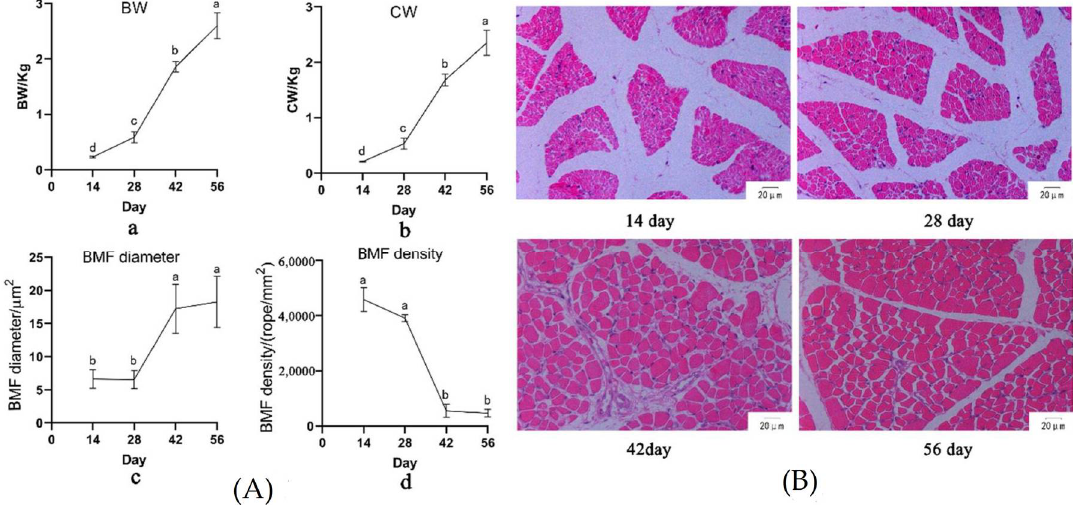
Figure 1. ( A ) Body weight (BW, a ), carcass weight (CW, b ), breast muscle fiber (BMF) diameter ( c ), and BMF density ( d ); ( B ) Hematoxylin-eosin (HE) section of breast muscle at different stages.